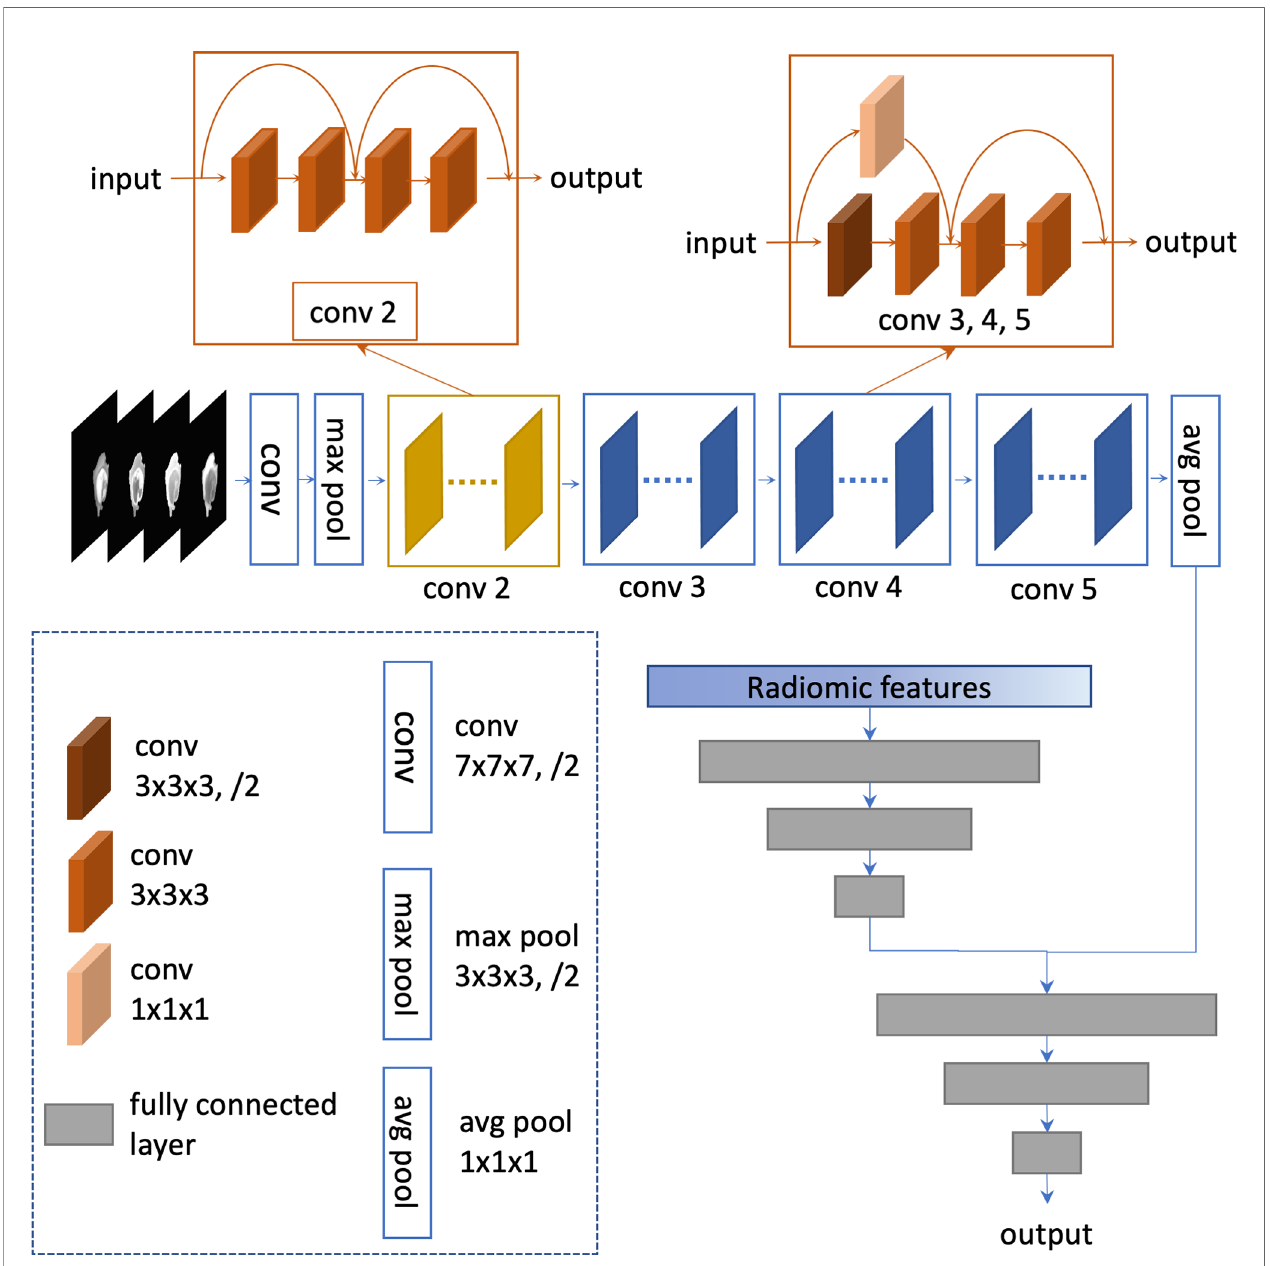
FIGURE 3 | Architecture of the integrated